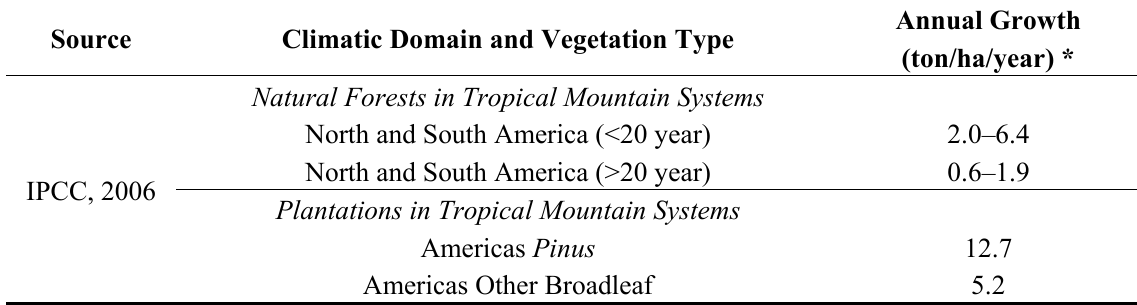
Table 1. Default values for annual biomass growth factors in Intergovernmental Panel on Climate Change (IPCC) guidelines.